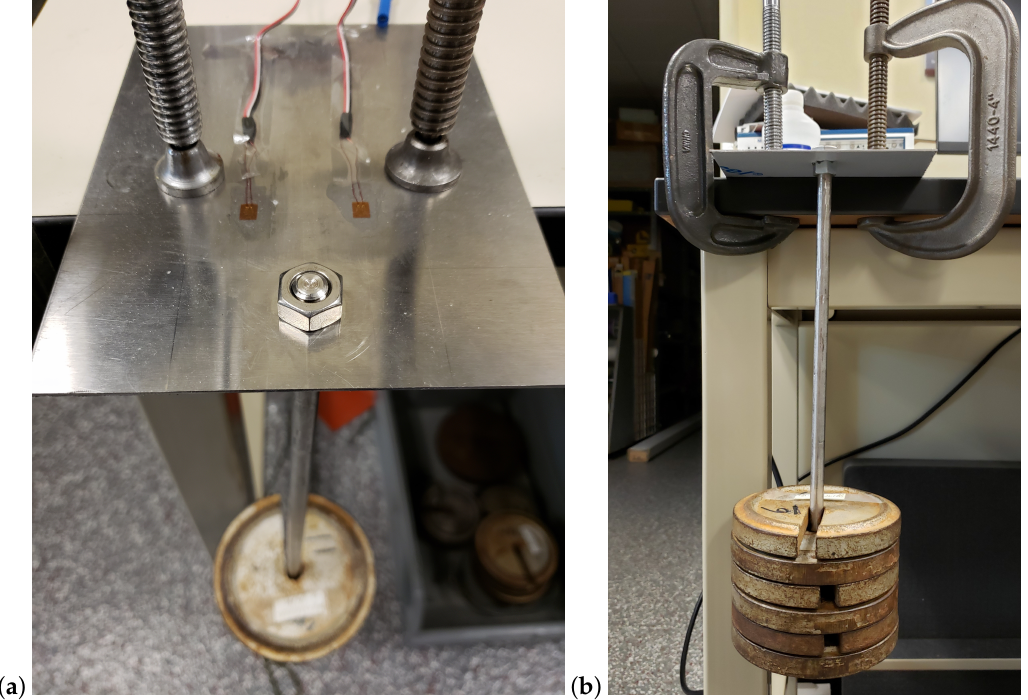
Figure 4. Load cell calibration test setup: oblique bird’s-eye view ( a ) and eye-level view ( b